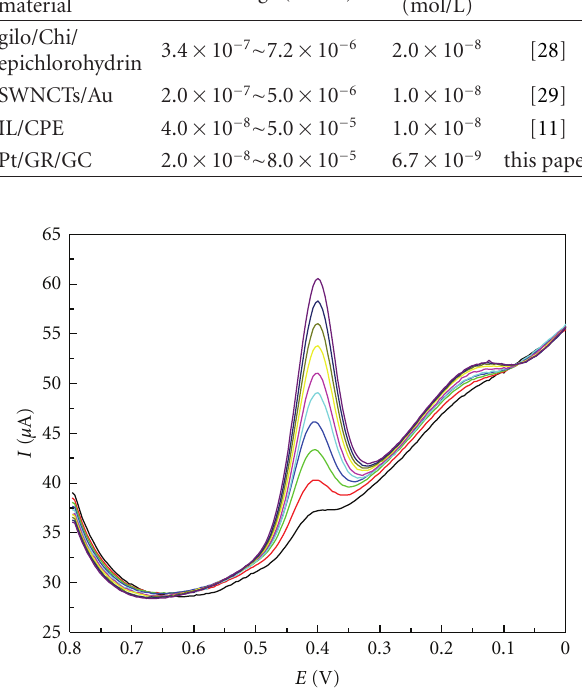
Figure 4: DPV curves of di ff erent concentrations of rutin in 0.1 M pH 5.0 phosphate bu ff er solution.